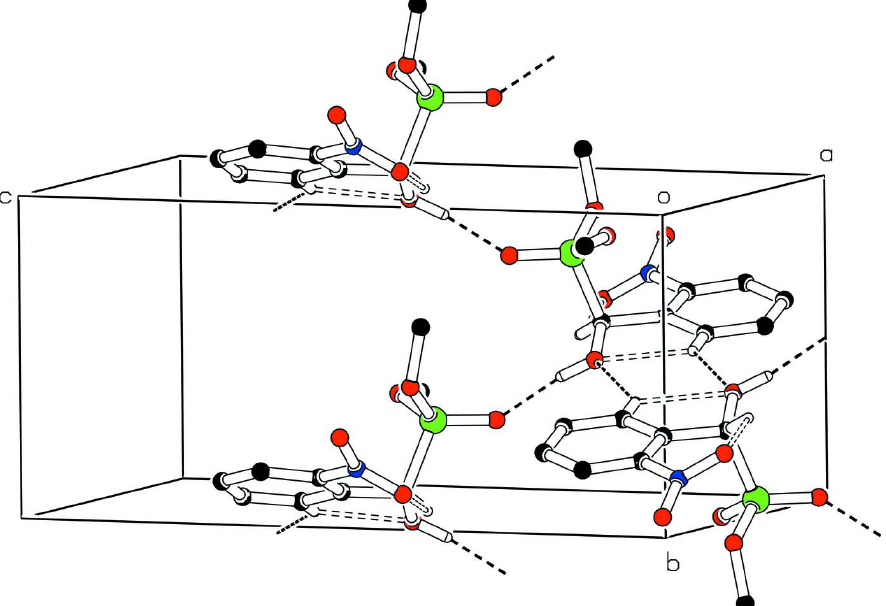
Figure 1 ORTEP drawing of the title compound, (C at the 50% probability level. H-atoms are shown by small circles of arbitrary radii. The broken lines indicate the intermolecular